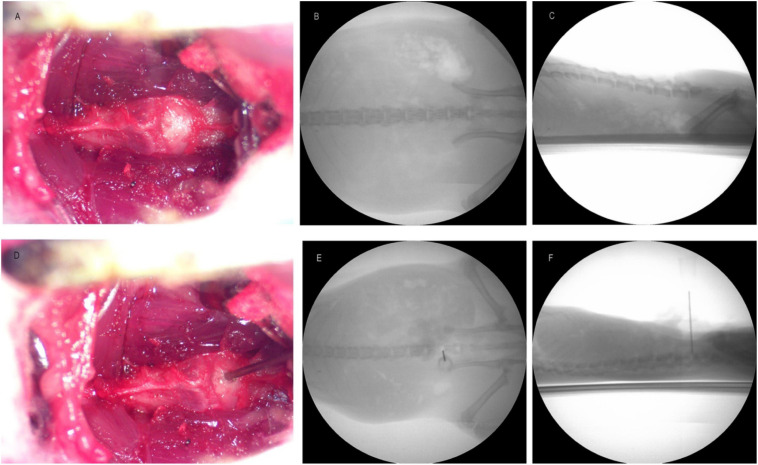
Panel (A) is the image of intervertebral disk before puncture. Panels (B,C) are the X-ray images of anterior and lateral position before puncture. Panel (D) is the picture of intervertebral disk during puncture. Panels (E,F) are the pictures of X-ray at the time of puncture.